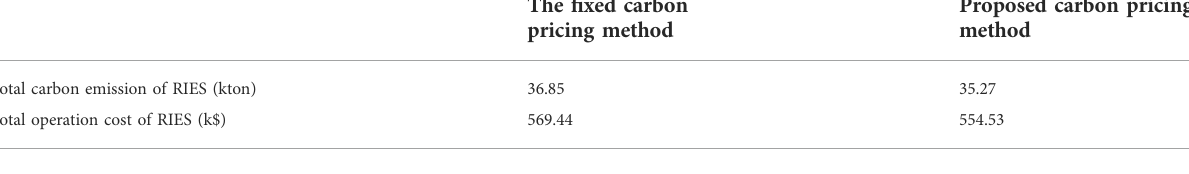
TABLE 7 Results for different carbon pricing methods.